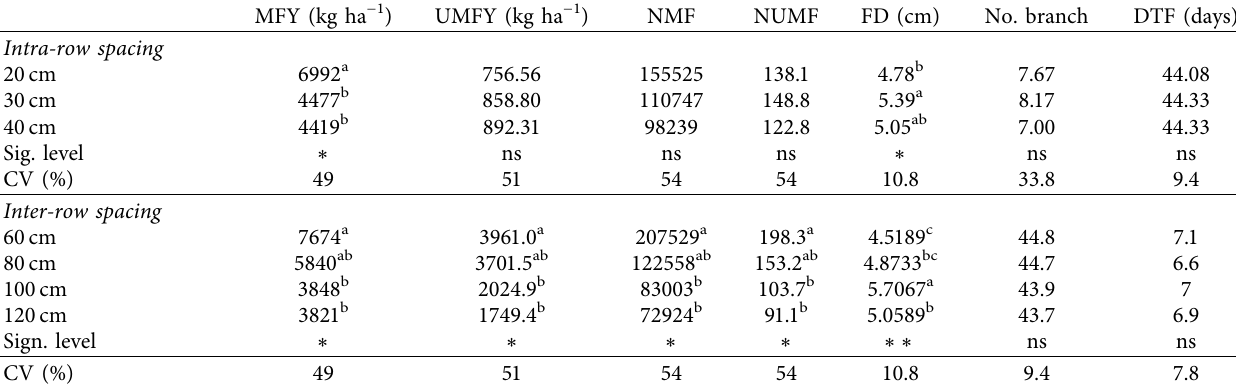
Table 1: Main effect of intrarow spacing on yield and yield components of tomato at Shewarobit